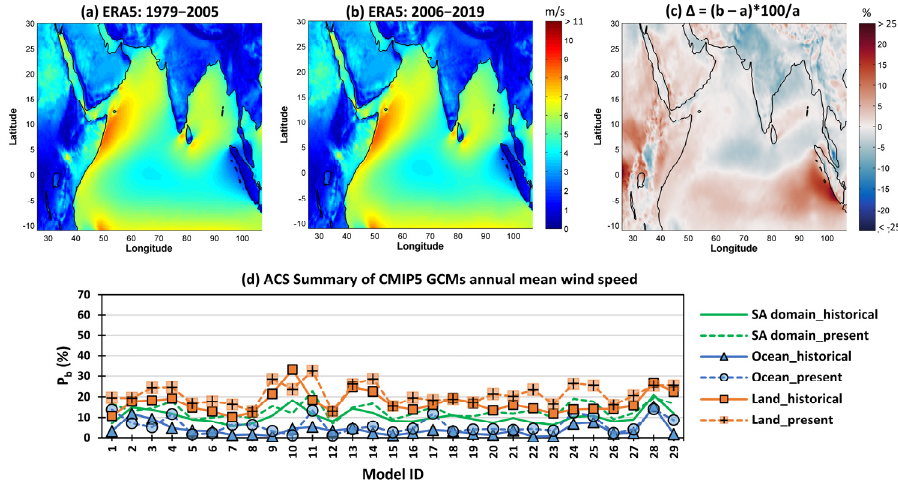
Figure 7. As in Figure 5, but for annual mean wind speed.